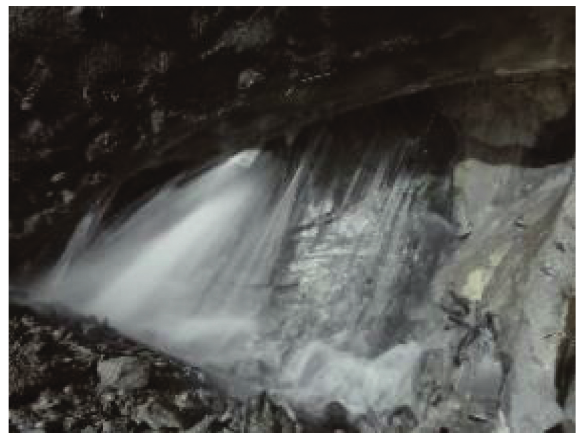
Figure 11: The tunnel water disasters.